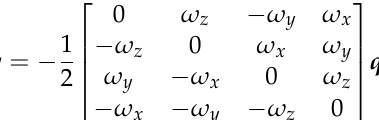
Figure 3. Stick diagrams of running motion and main gait events.